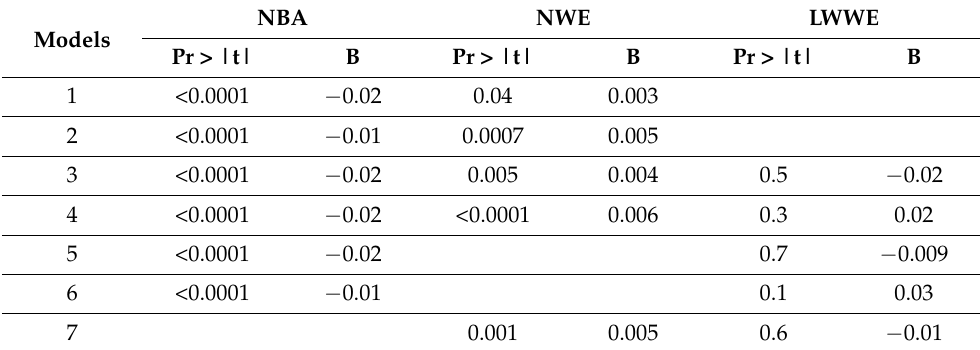
Table 7. Estimated trends for Landrace.